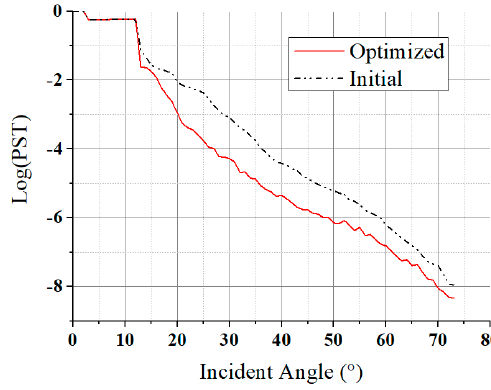
Figure 11. Evaluation of lens stray light after optimization.